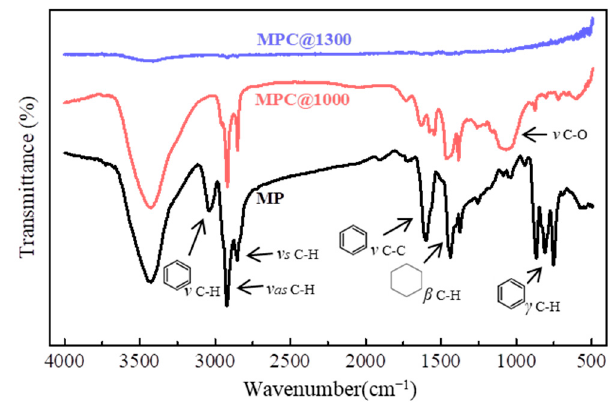
Figure 4. Infrared spectra of MP, MPC@1000, and MPC@1300.